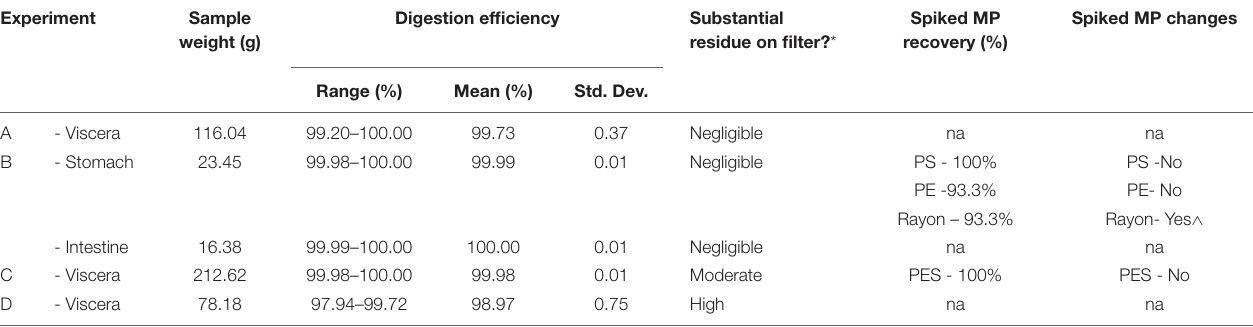
TABLE 3 | The digestion efficiency and recovery of spiked MPs (polyethylene PE, polystyrene PS, polyester PES and rayon) in the four Experiments (A–D). Experiment Sample weight